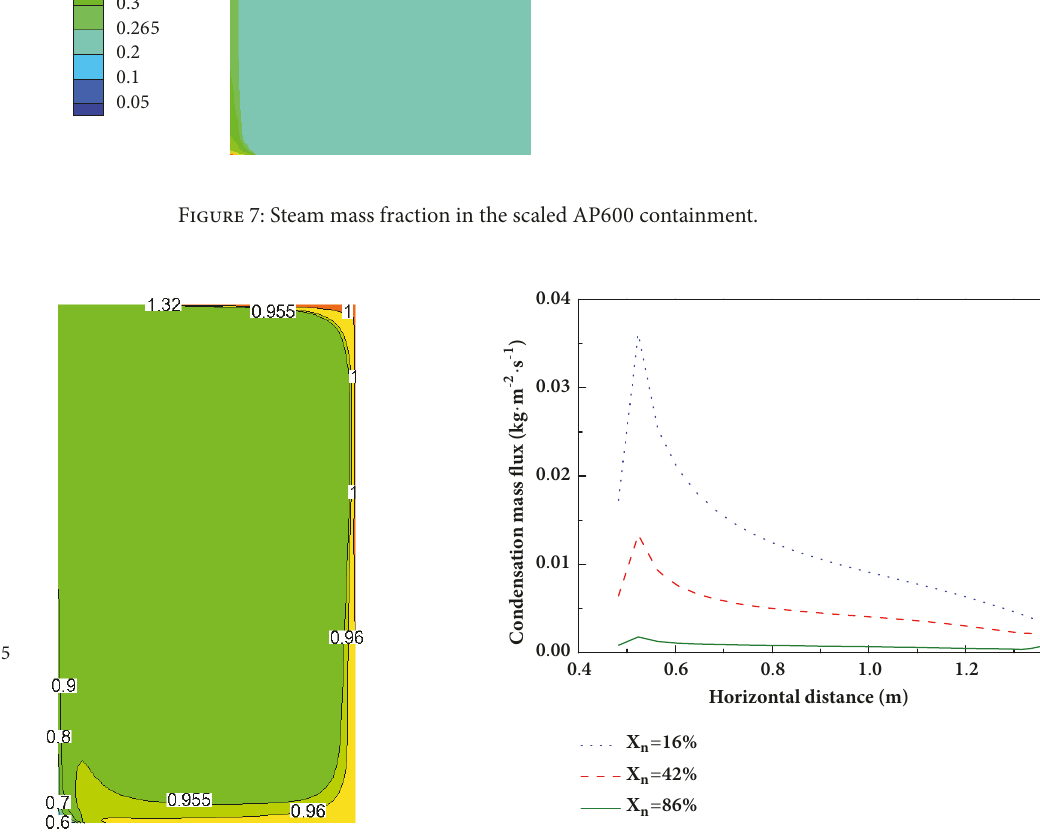
4.2. Heat and Mass Transfer. The distributions of conden- sation mass flux and heat flux along the upper header and vertical walls are shown in Figure 16. The horizontal axis represents the distance along the wall from the axis. The dotted line represents the separation point for the upper head and the vertical wall. It can be seen that the condensation mass flux and heat flux at the upper cover (or upper head) wall are larger than that at the vertical wall. This is because